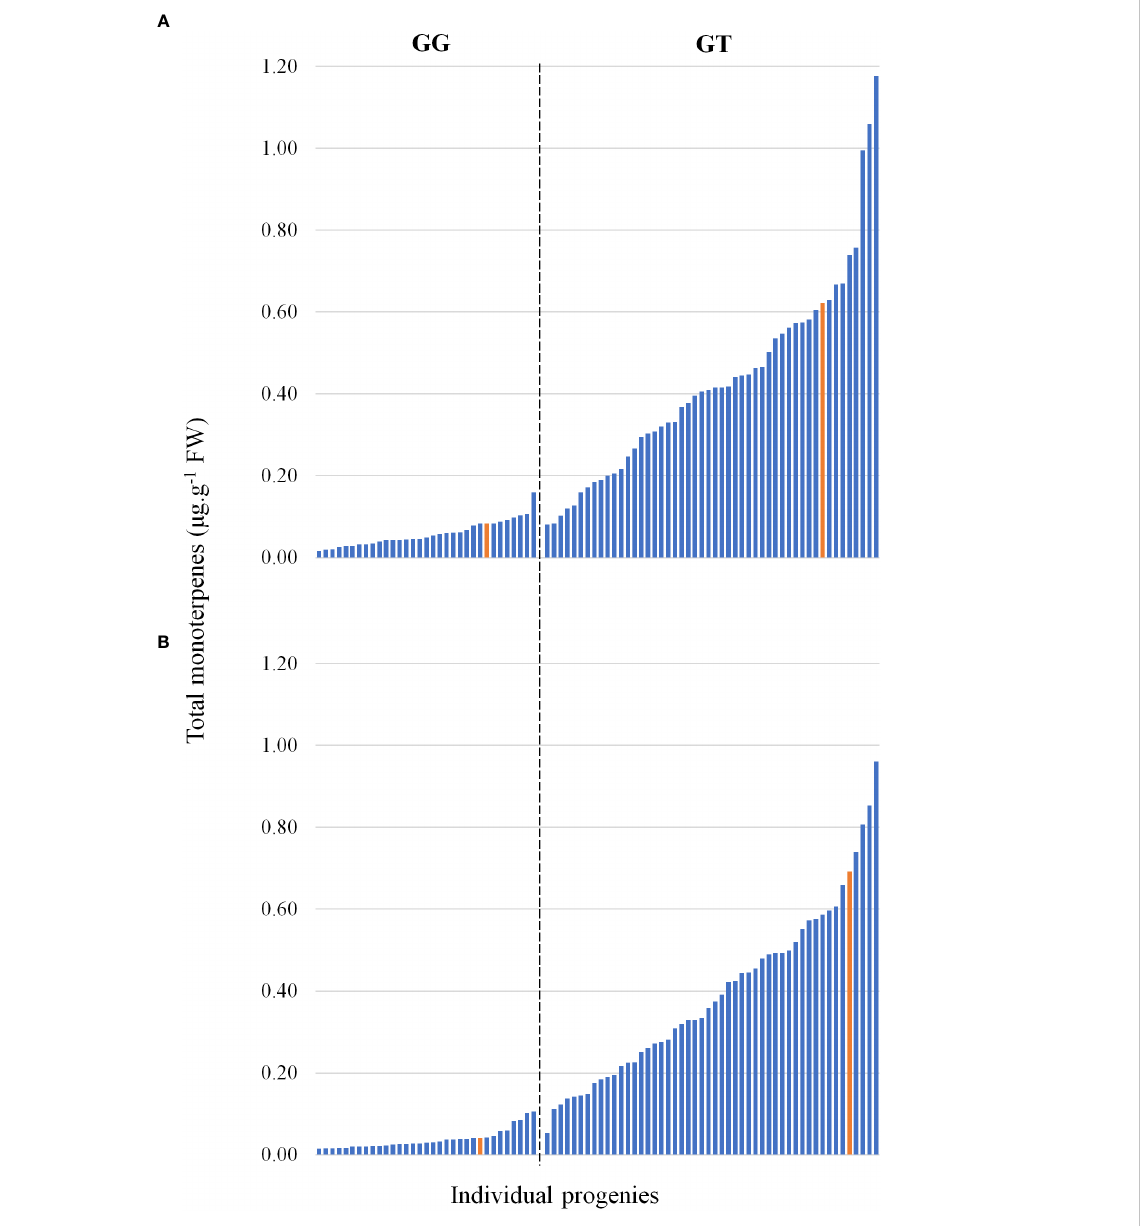
FIGURE 4 The total monoterpene content in the mapping progeny at (A) pre-veraison and (B) veraison. Each bar represents a member of the progeny, and the parents are shown in yellow. The bars are grouped into absence/presence of the VvDXS1